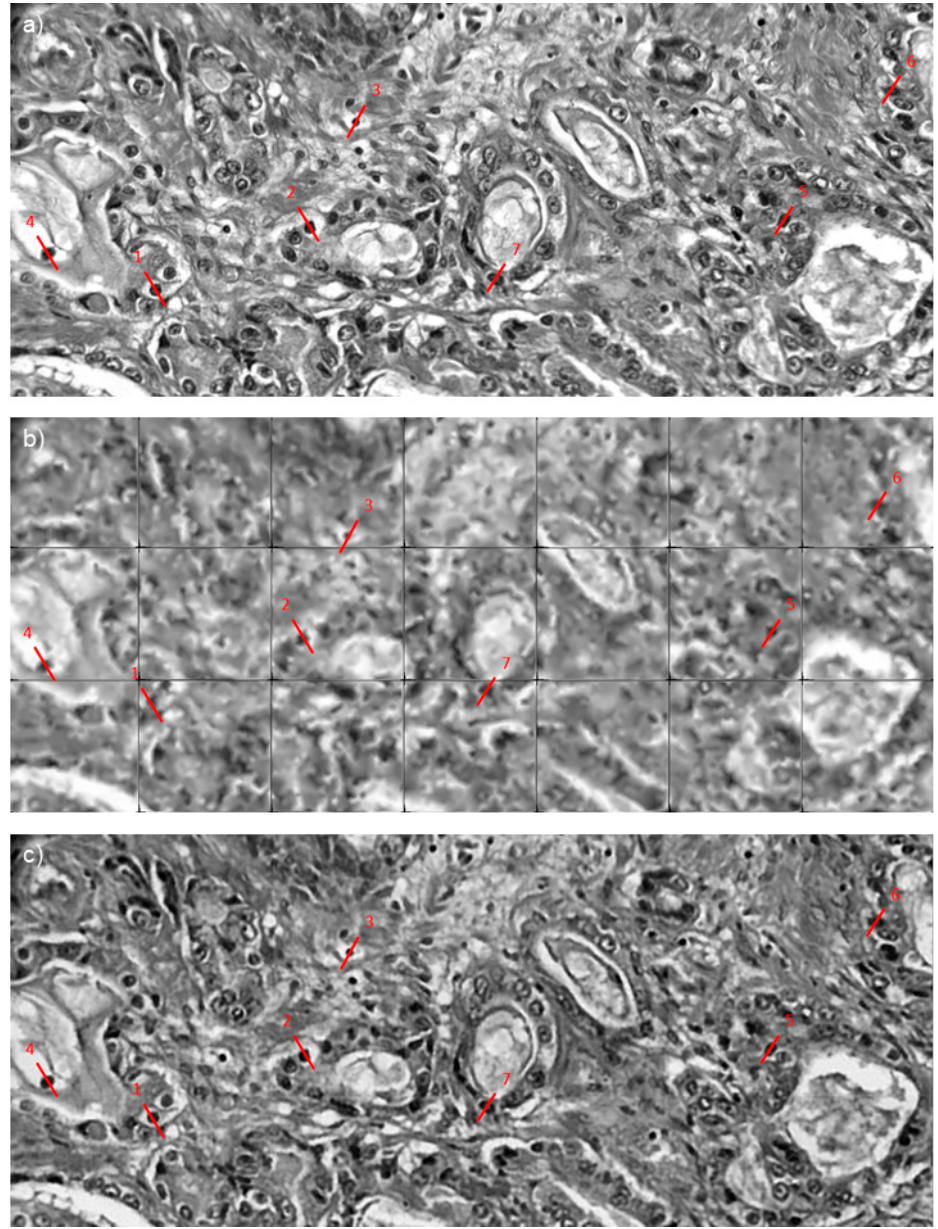
Figure 6. SR reconstruction of slices taken from images prostate tissue (cancer and non-cancer) slide. ( a ) ground truth image. ( b ) Linear interpolation. ( c ) MFAE. Red lines represent line profile taken of cell nuclei, line numbering is equivalent to cell numbers in Table 2. Table 2. Comparison of cell nuclei sizes